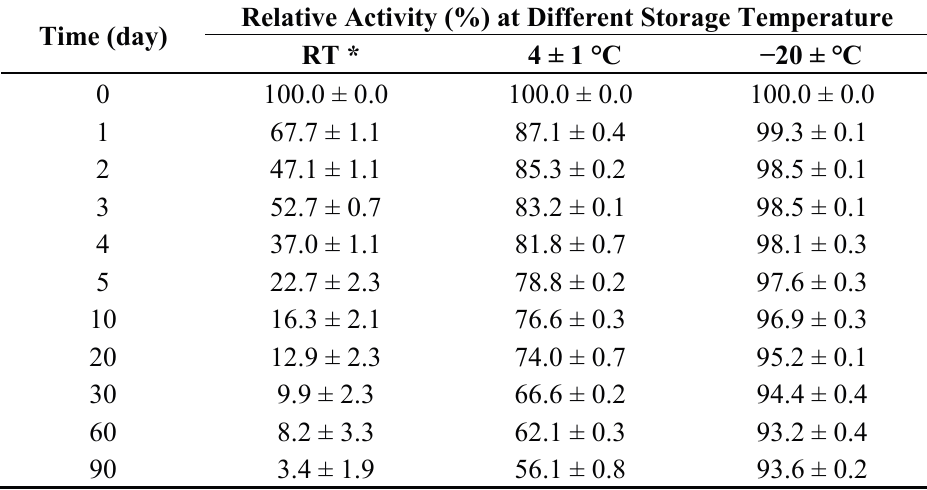
Table 3. Effect of storage temperature on activity of bentong ginger